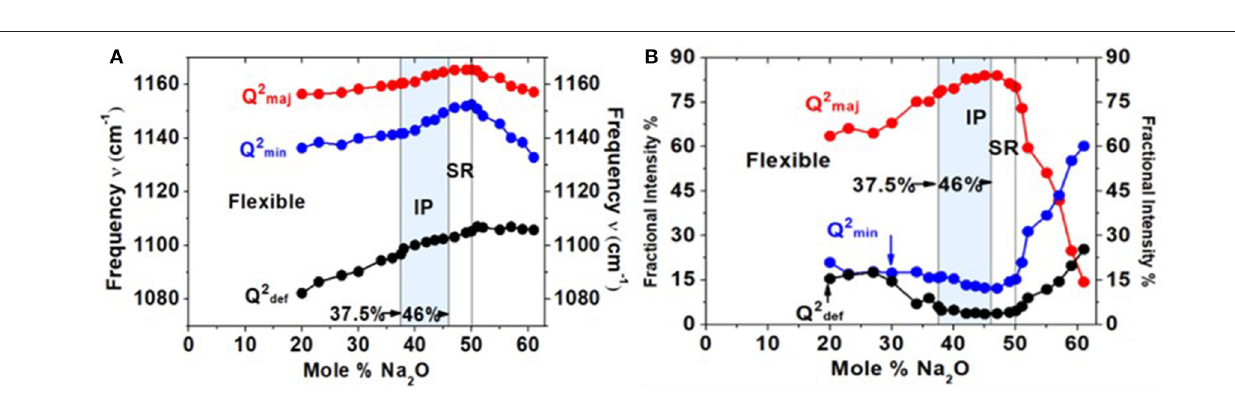
FIGURE 10 | (A) Mode frequency and (B) mode scattering strength variation of the triad of modes associated with the Q 2 local structure as a function of x. All modes blue-shift with glass composition in the 20% < x < 50% range. The scattering strength variation (B) shows that the majority mode (red dataset) increases in scattering strength with x; the minority mode (blue dataset) and defect band (black dataset) show a global minimum in the intermediate